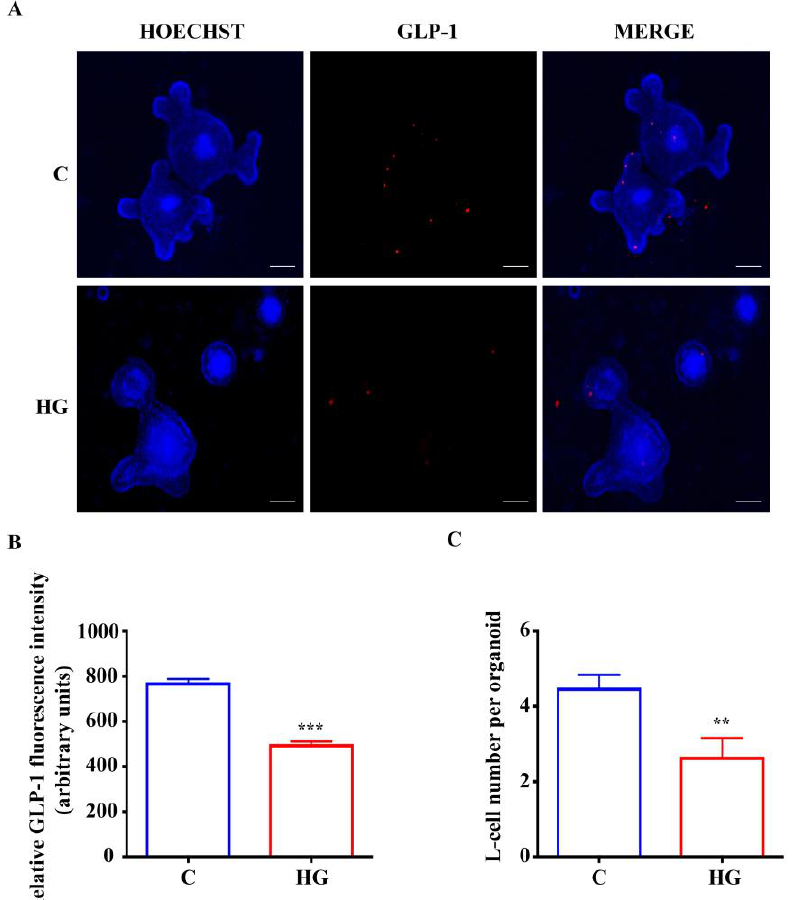
Figure 6. Expression of GLP-1 in small intestinal organoids. ( A ) Representative images of controls and organoids treated with high glucose (35 mM) for 48 h. L-cells, inside organoids, are labeled in red by GLP-1 expression. Nuclei are labeled by Hoechst. Scale bar, 50 μm. ( B ) Quantification of the GLP-1 fluorescence intensity. ( C ) L-cell numbers in control organoids and organoids treated with high glucose. (n = 6). Data are expressed as means ± SEM. Unpaired Student t -test: ** p < 0.01, *** p < 0.001. C = Control (17.5 mM glucose). HG = High Glucose (35 mM glucose).